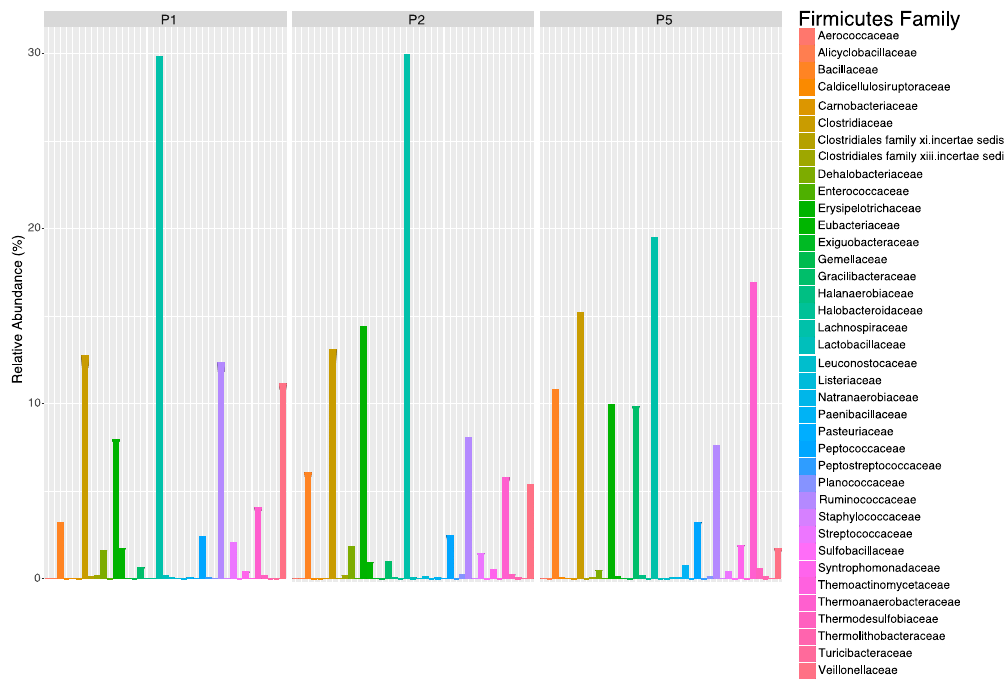
Figure A3. Relative abundance of the 39 Firmicutes families in Ponds 1, 2 and 5. Table A5. Relative abundance for Firmicutes families above 0.1% A * = Pond-indicator